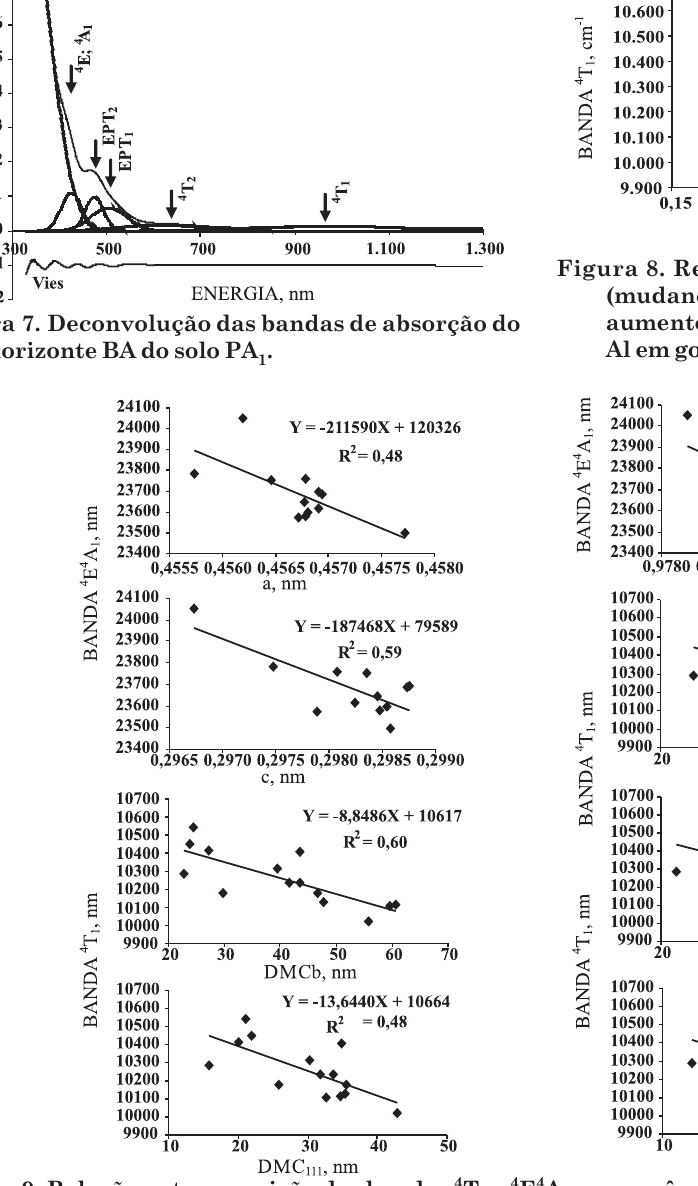
e 4 E 4 A e os parâmetros cristalográficos da 1 1